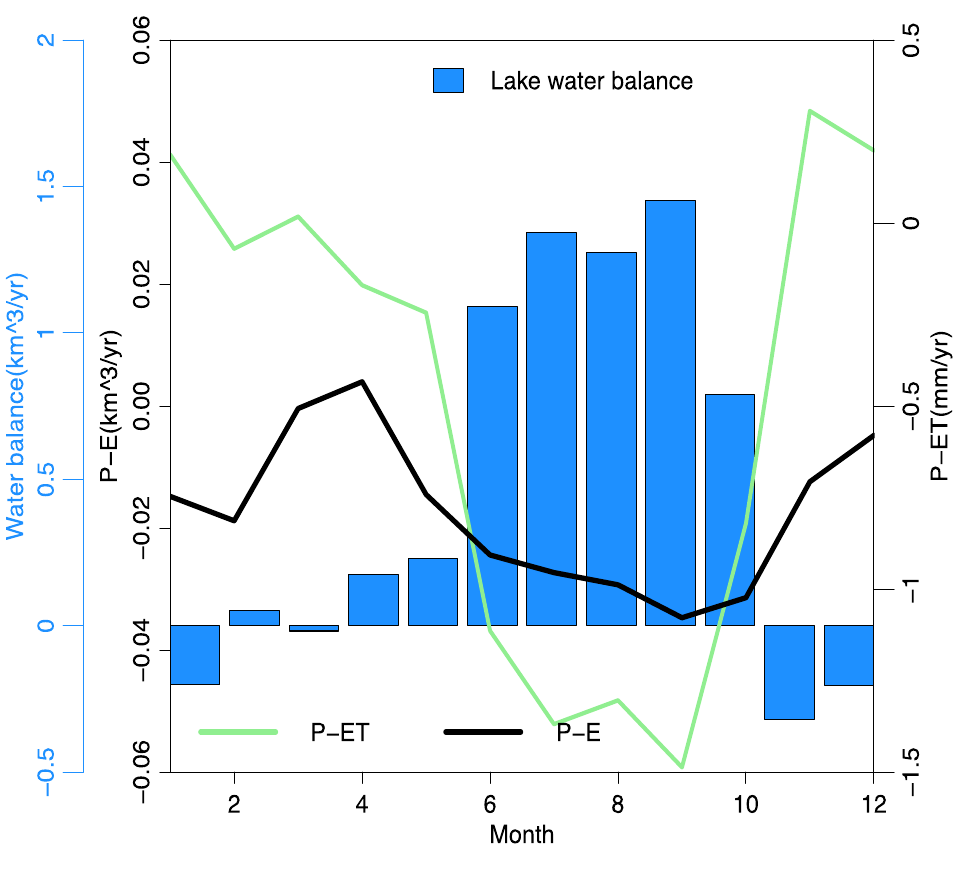
Figure 13. Monthly means water balance parameter of Lake Manyara (2001–2009): Precipitation-Evapotranspiration (P-ET), Precipitation-Evaporation (P-E) and their weighted combination Lake Water